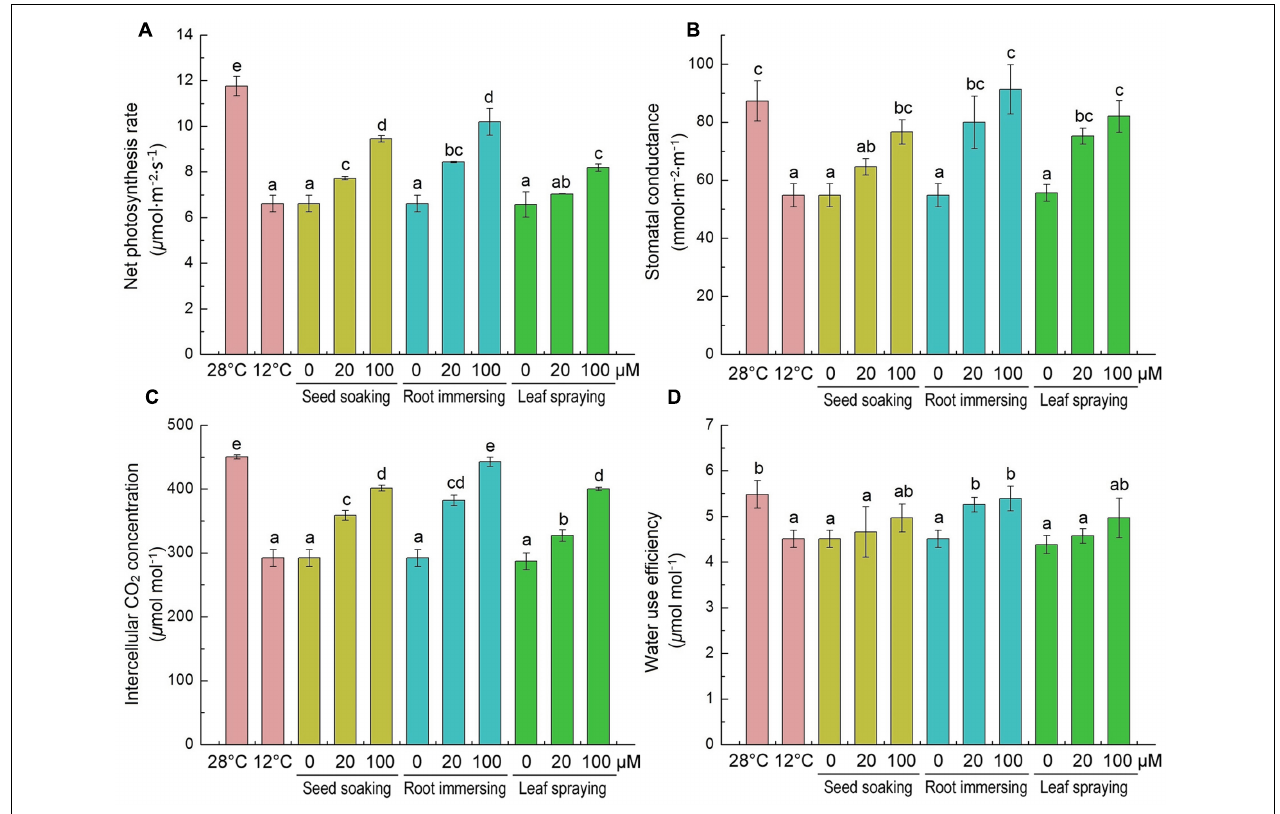
FIGURE 6 | Effects of exogenous melatonin on net photosynthetic rate ( P n ) (A) , stomatal conductance ( G s ) (B) , intercellular CO 2 ( C i ) (C) and water use efficiency (WUE) (D) after 6-day cold stress (12 ◦ C). Others are the same as in Figure 1